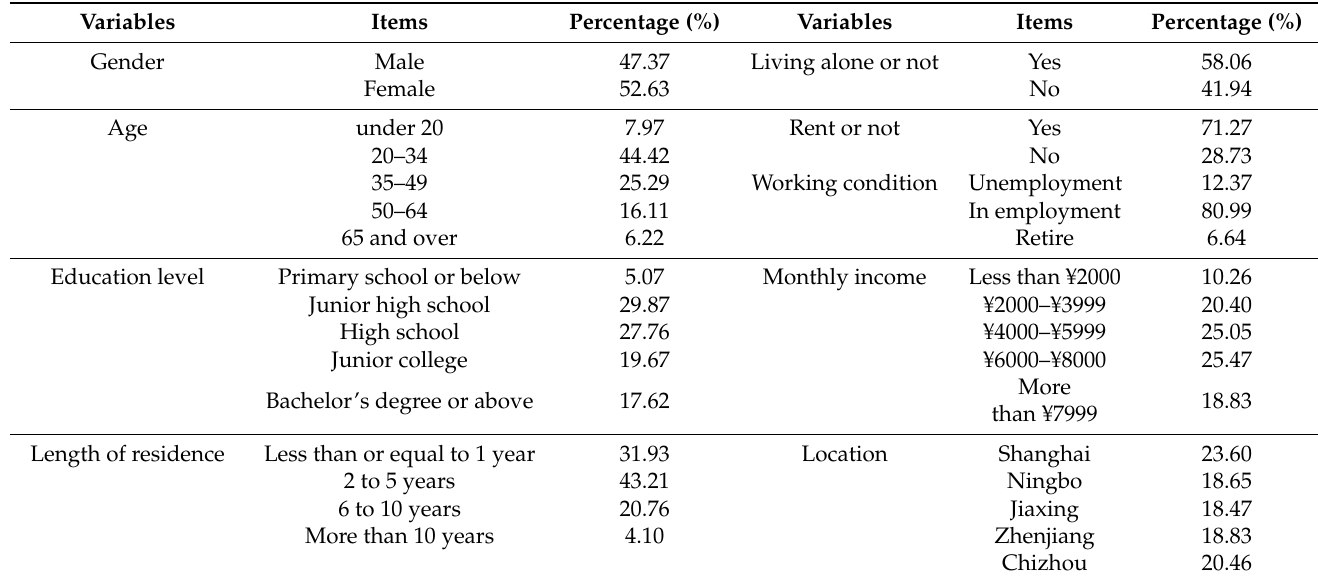
Table 1. Descriptive statistics of individual